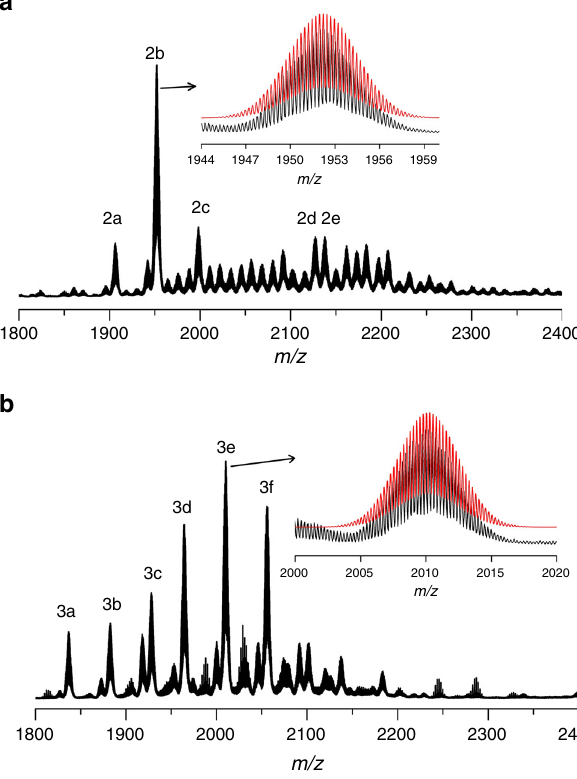
Fig. 6 The solution behaviours of SD/Ag8 and SD/Ag9 . Positive-mode ESI- MS of SD/Ag8 ( a ) and SD/Ag9 ( b ) dissolved in acetonitrile. Insets: Comparison of the experimental (black spectrum) and simulated (superimposed red spectrum) isotopic envelopes for 2b and 3e